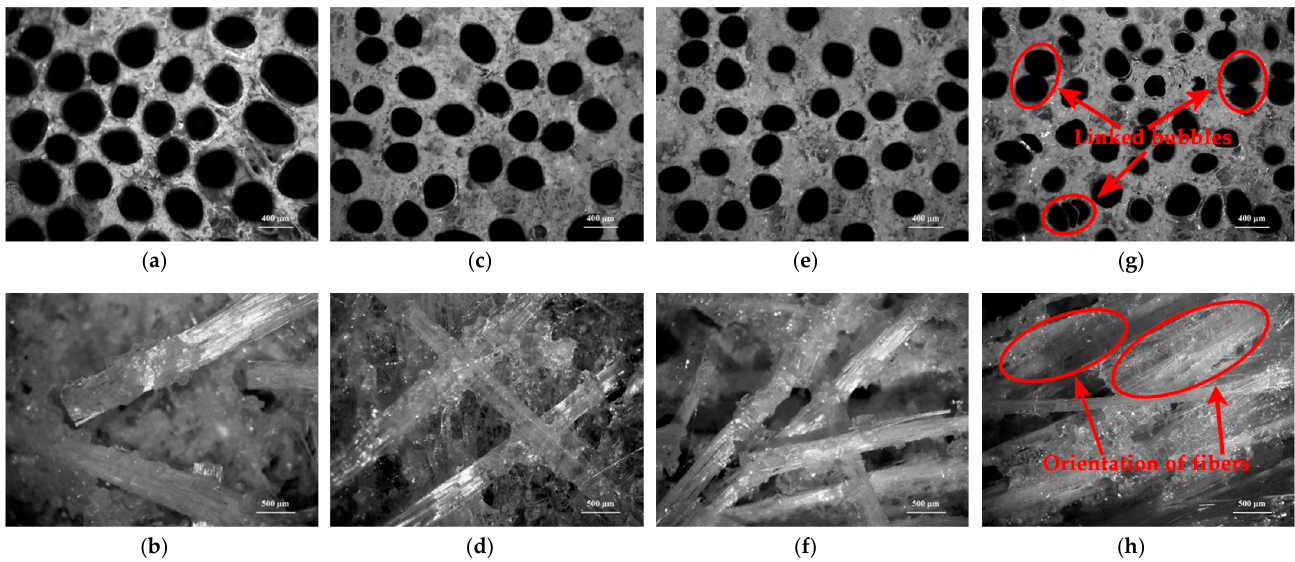
Figure 11. Micrographs of cured samples with the presence of 15.0 mm long chopped glass fiber, with the coexistence of MEKP-II and cobalt naphthenate: ( a , b ) cured LCGFR-LDUPR composite specimen with the presence of 10.00 phr of long chopped glass fiber, ( c , d ) cured LCGFR-LDUPR composite specimen with the presence of 15.00 phr of long chopped glass fiber, ( e , f ) cured LCGFR-LDUPR composite specimen with the presence of 20.00 phr of long chopped glass fiber, ( g , h ) cured LCGFR-LDUPR composite specimen with the presence of 25.00 phr of long chopped glass fiber.